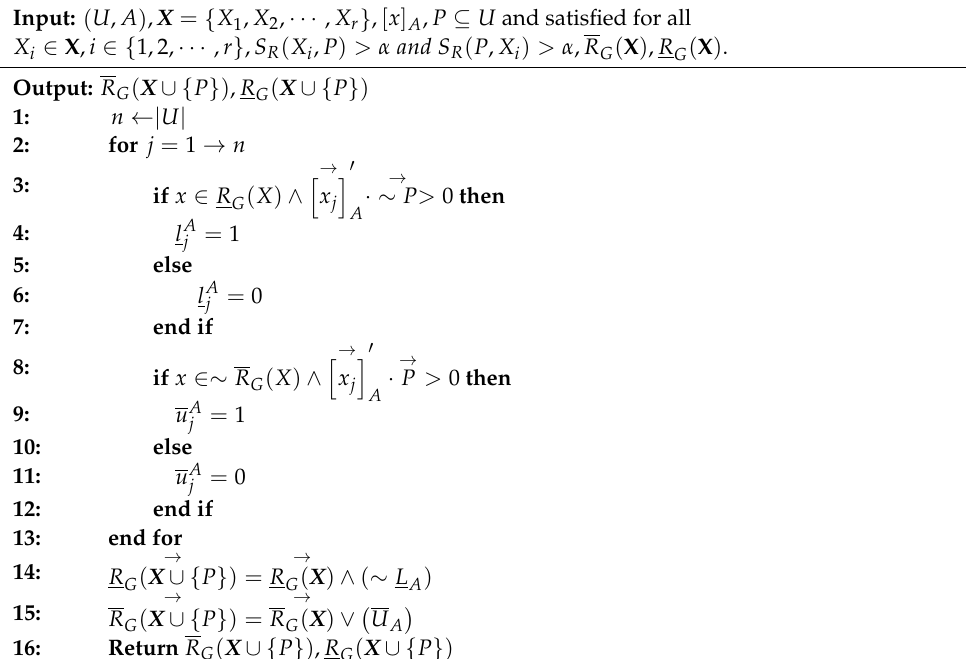
Algorithm 2. Dynamic Computing Approximations of a GMTRS while Adding a Target Concept